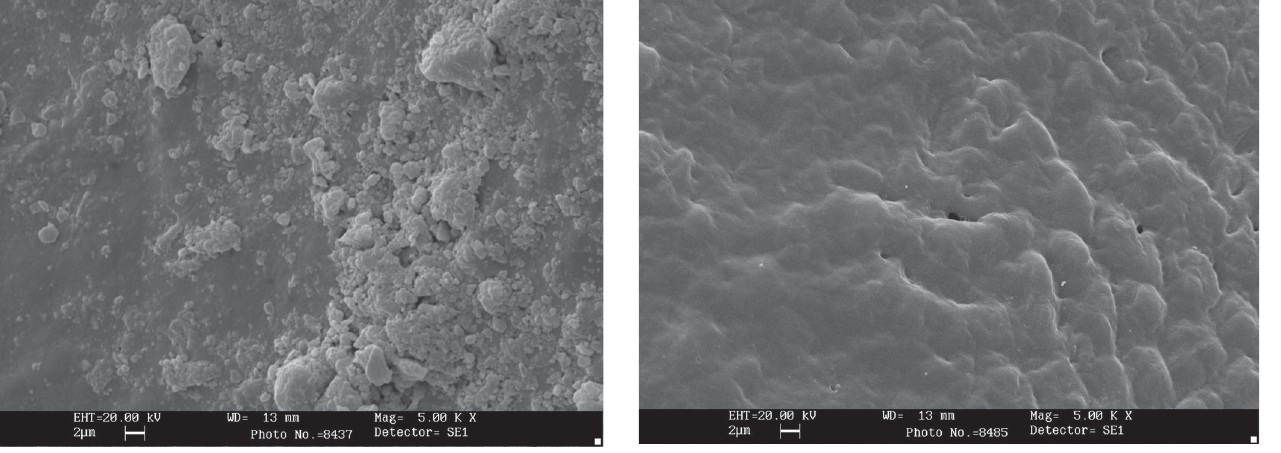
Fig. 4 - SEM image of the ScaEdta group showing complete removal of smear layer and no EDTA residues.